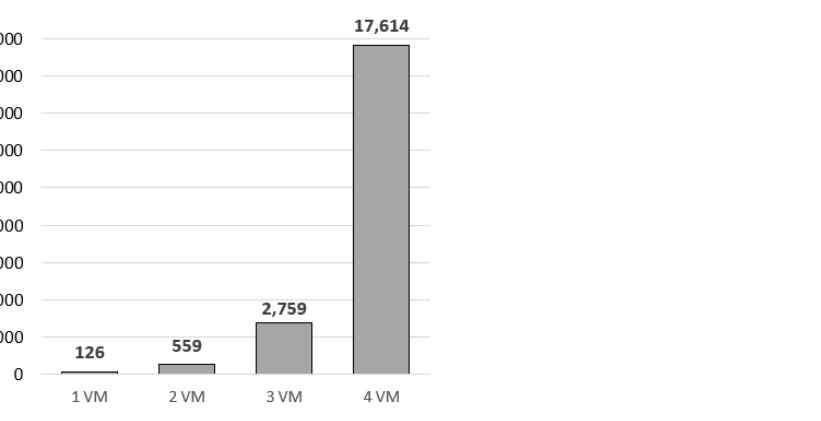
Figure 7. Total time in seconds to traverse the execution tree during automatic debugging.